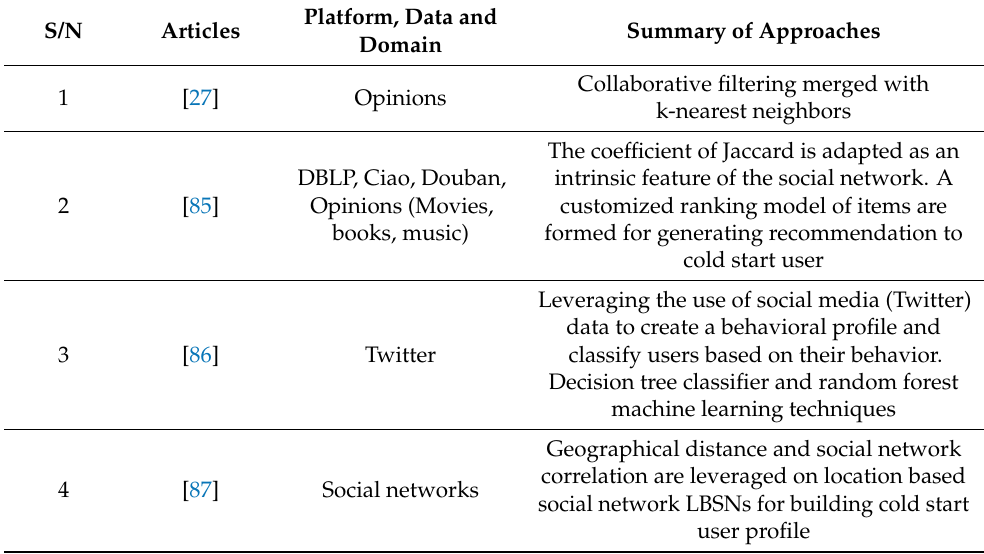
Table 4. Building social network profile for cold start